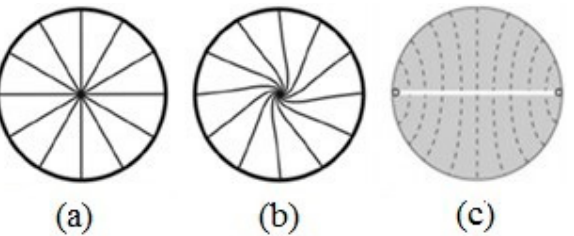
Figure 6. Director’s field schematization for a spherical droplet in homeotropic anchoring condi- tions: ( a ) radial drop, ( b ) twisted radial drop ( c ) ring defect located on the surface of the drop along one of the two equatorial lines. Reprinted with permission from ref. [36]. Copyright 2011, Springer Nature.